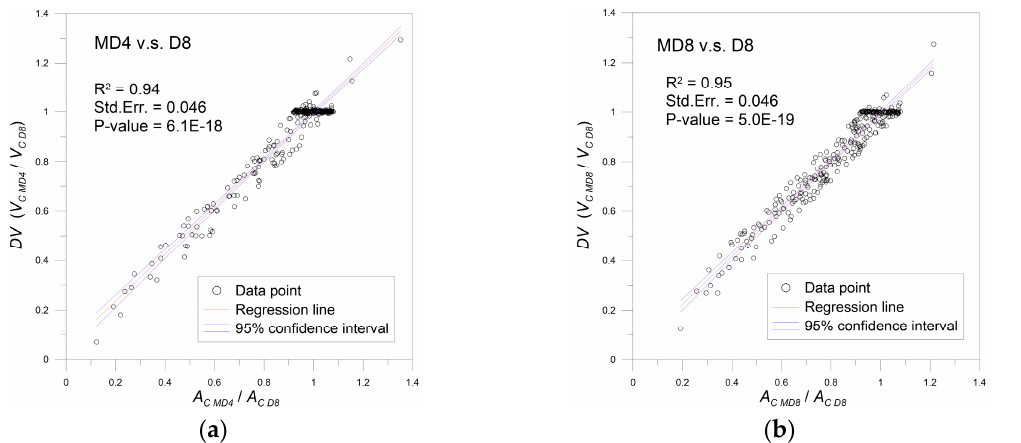
Figure 10. Relationship between the flow-volume deviation ( DV ) and the ratio of flow concentration area: ( a ) MD4 compared to D8; ( b ) MD8 compared to D8.